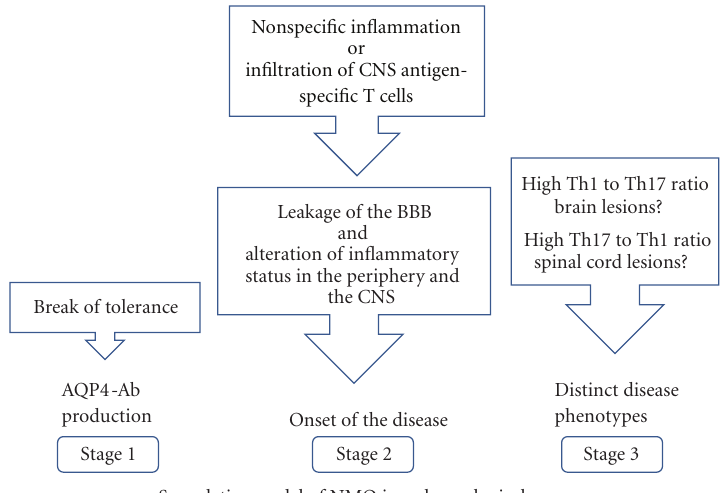
Figure 1: Speculative model of AQP4-Ab-positive NMO is shown in a chronological manner. At the very first stage of the disease course, break of tolerance against AQP4 leads to production of AQP4-Ab in the periphery without manifesting any symptoms. What causes the compromise of the tolerance is not yet elucidated. Molecular mimicry of AQP4 to certain microbes is one of the possibilities. Onset of the disease might be triggered by either nonspecific inflammation caused by infections or activation of CNS antigen-specific T cells. These stimuli will not only induce the leakage of the BBB, but also alter the inflammatory status both in the periphery and within the CNS. Once the disease develops, the location of the lesions may be determined by the types of T cells infiltrating within the CNS. The presence of AQP4-Ab will further modulate the disease phenotype and produce characteristic lesions of NMO spectrum disorders.